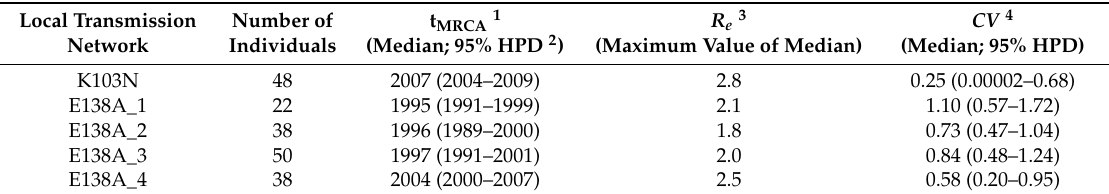
Table 1. Characteristics for the five local transmission networks